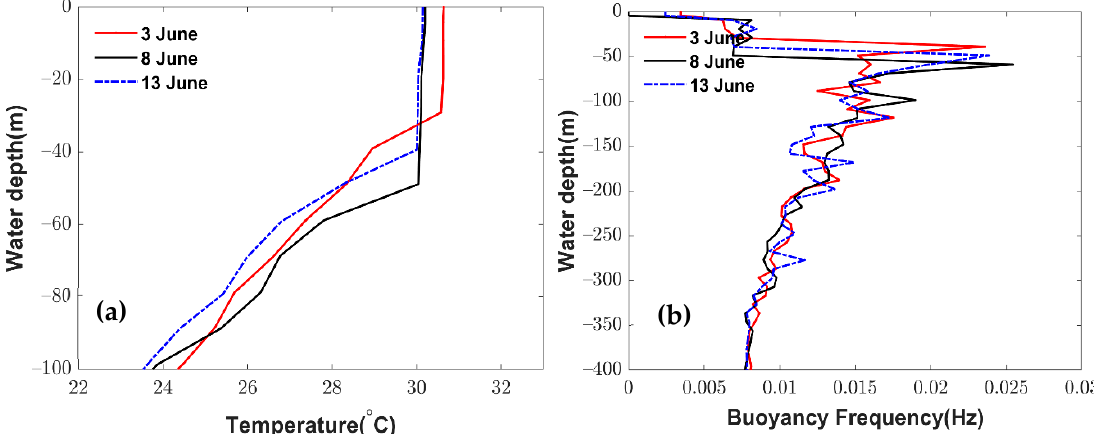
Figure 14. ( a ) Measured water temperature by Argo float 2900556 for 3, 8, and 13 June for the upper 100 m of the water column. ( b ) Calculated buoyancy frequency for the upper 400 m.